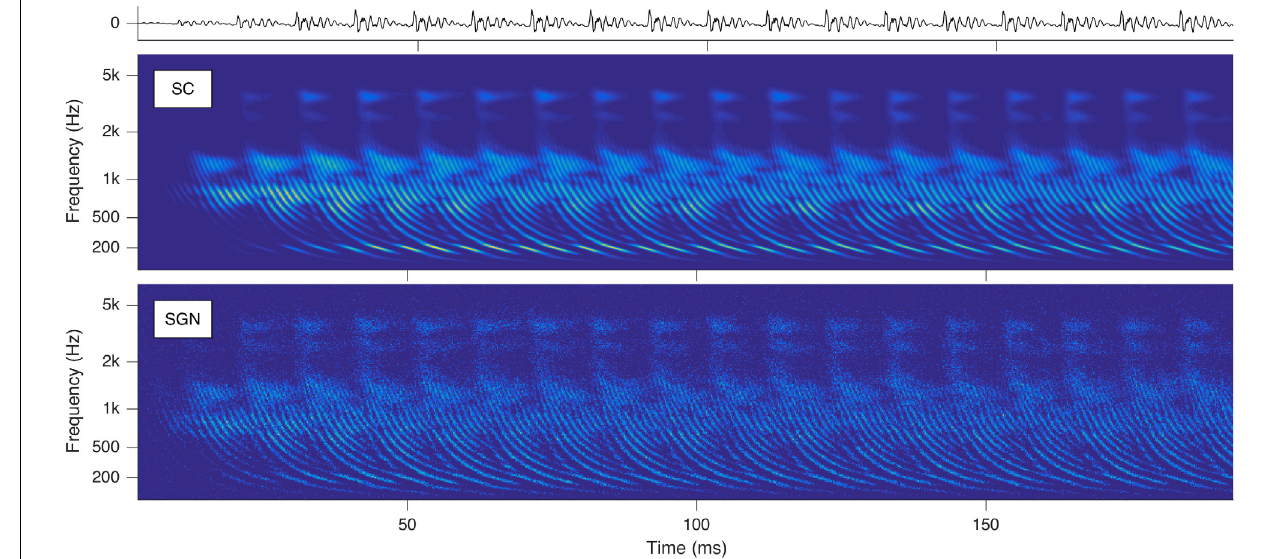
FIGURE 1 | Cochleagrams with quasi-stationary repetitive patterns for a short snippet of the vowel a: sung by a male singer at the note of G2. Top: Sound signal waveform. Middle: Probability (ascending from blue over green to yellow) of neurotransmitter substance release into the synaptic cleft (SC) as a function of time and place within the cochlea. Bottom: Action potentials of the spiral ganglion neurons (SGN). Note that the ordinate shows the characteristic frequency of the basilar membrane model at the corresponding cochlear position (Reprint from Harczos and Klefenz, 2018).